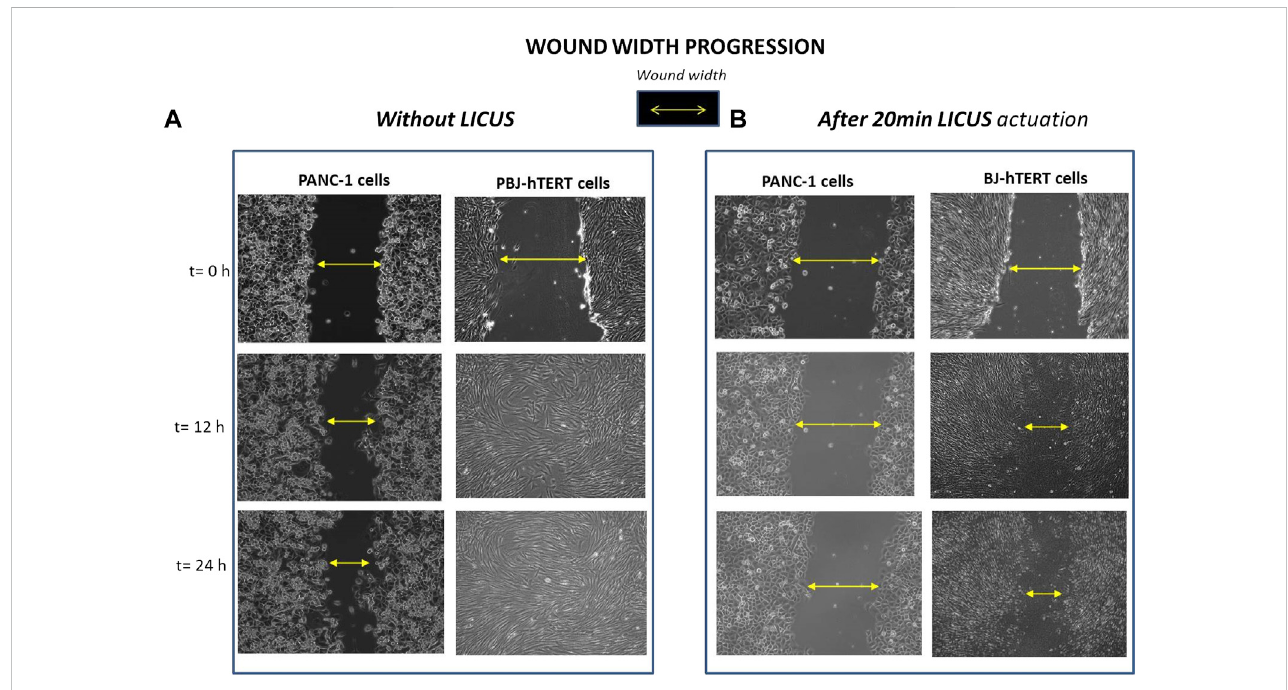
FIGURE 6 Wound width progression fi lmedovertime inPANC-1 and FibroblastBJ-hTERT monolayer samples respectively: (A) without LICUSexposure before the culture; (B) after 20min LICUS